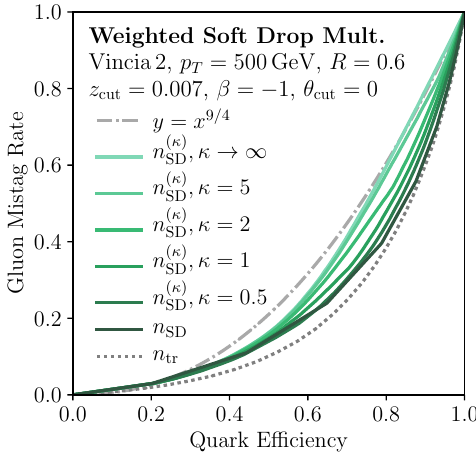
Figure 19. Quark/gluon discrimination power of weighted soft drop multiplicity as a function of (cid:20) , at the benchmark parameters from eq. (2.7). We also show the limit (cid:20) to max( z n